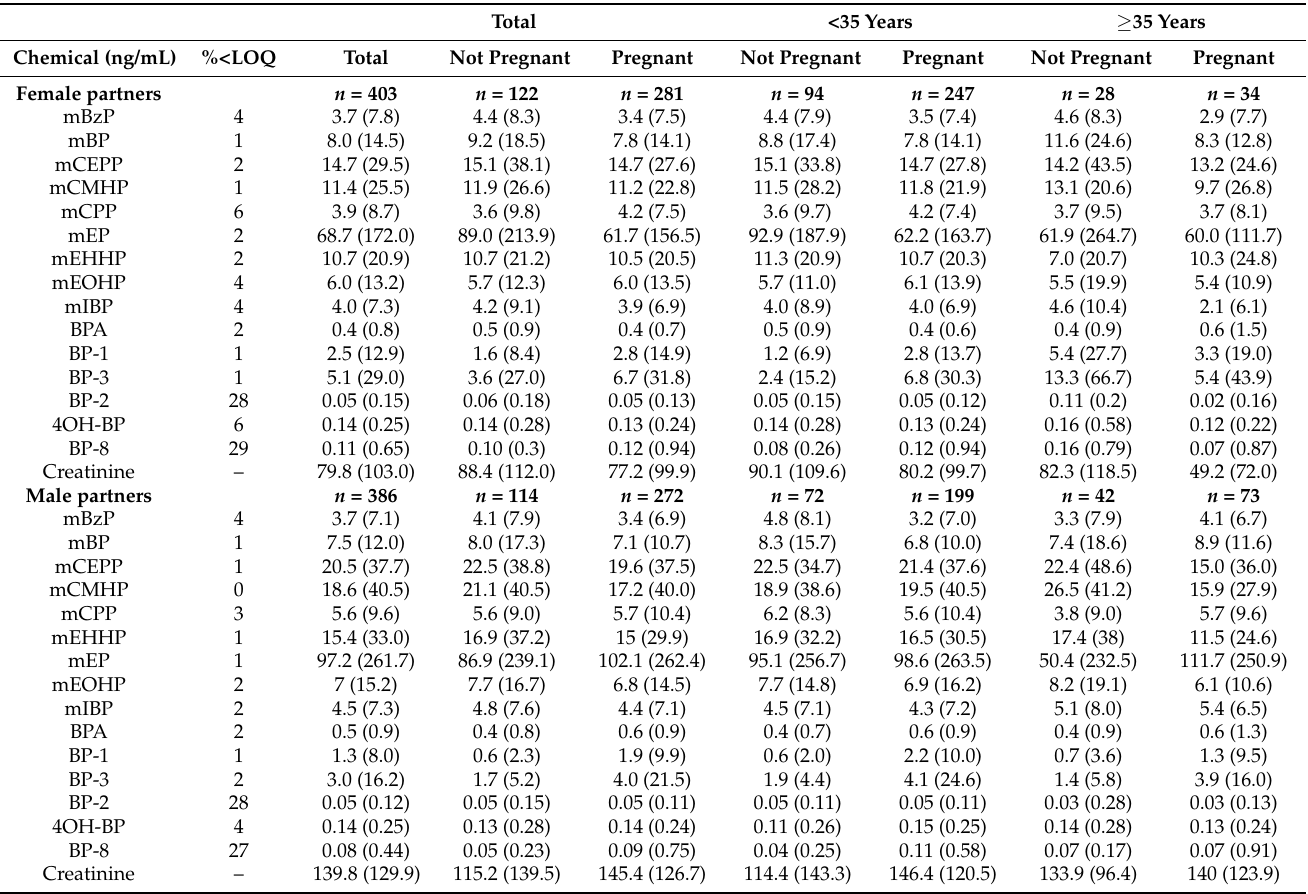
Table 2. Phthalate metabolite and ultraviolet filter concentrations [median (interquartile range)] (ng/mL) by pregnancy status, age category, and sex among participants in the Longitudinal Investi- gation on Fertility and Environment Study in Michigan and Texas (2005–2009).